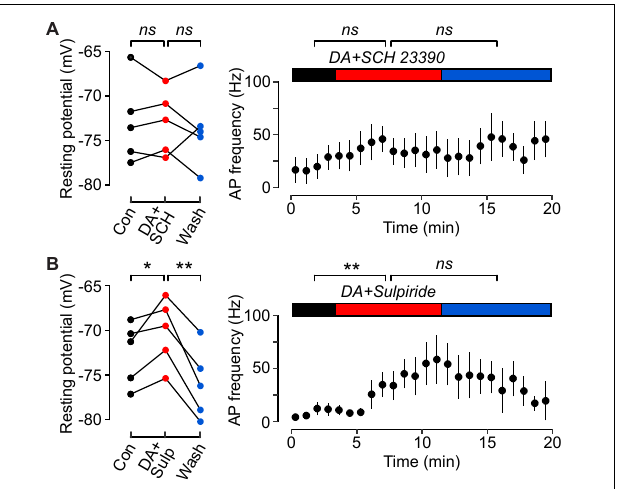
FIGURE 4 | Dopamine D1-class receptors mediate the dopamine-induced increase in intrinsic excitability of FS cells. (A) (Left), Resting potentials of n = 5 FS cells in control (black), in 10 µ M DA plus 10 µ M of the D1-class antagonist, SCH 23390 (red), and wash (blue). Lines connect data points for the same cell. (A) (Right), Plot of mean action potential frequency vs. time for the same FS cells. Horizontal colored bars indicate the control, DA plus SCH 23390 and wash periods. SCH 23390 blocks the effect of dopamine on FS cell excitability. (B) Similar experiments with dopamine plus 10 µ M of the D2-class antagonist, RS-sulpiride ( n = 5 FS cells). RS-sulpiride does not block the DA-induced increase in excitability. ** p < 0.01; * p < 0.05; ns , not